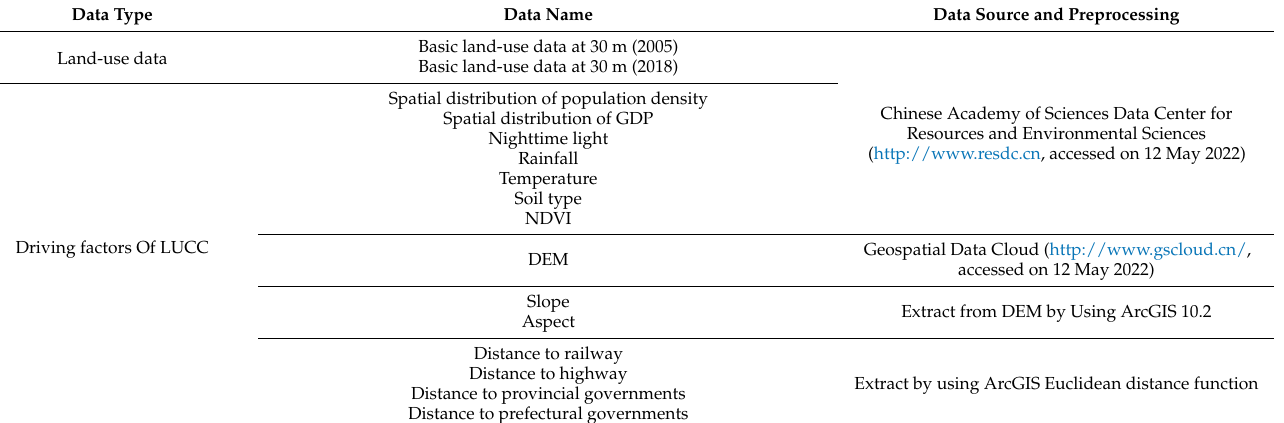
Table 1. Data information and